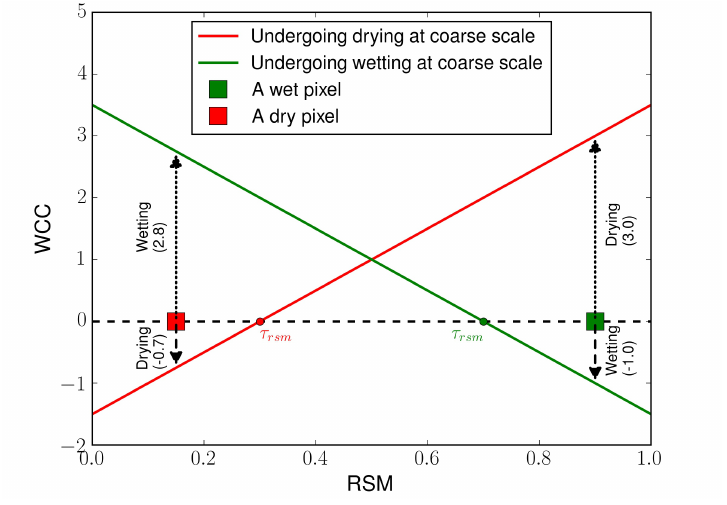
Figure 6. Conceptual relationship showing the behaviour of WCC with respect to the RSM for a dry and a wet